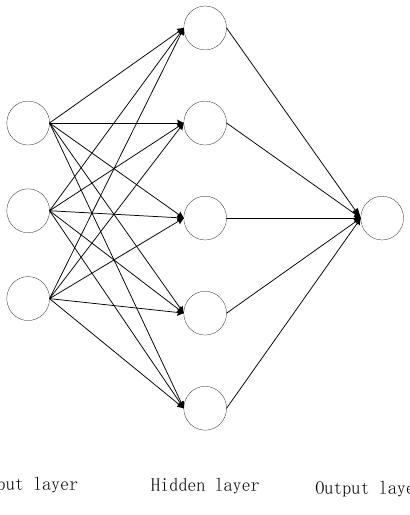
Figure 2. Structure diagram of BP neural network.